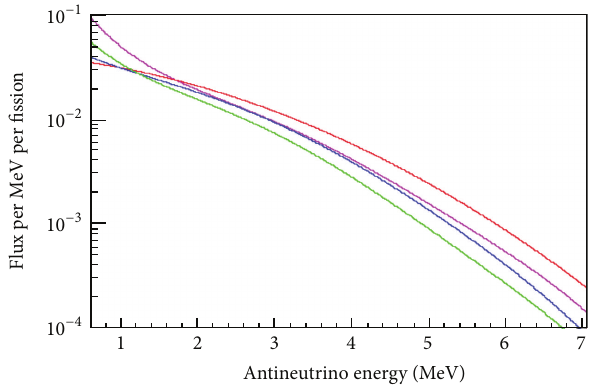
Figure 4: Energy spectra of antineutrinos released in the fission of the main isotopes ( 235 U (cyan), 238 U (red), 239 Pu (green), and 241 Pu (blue)) used as the fuel in the cores of nuclear power